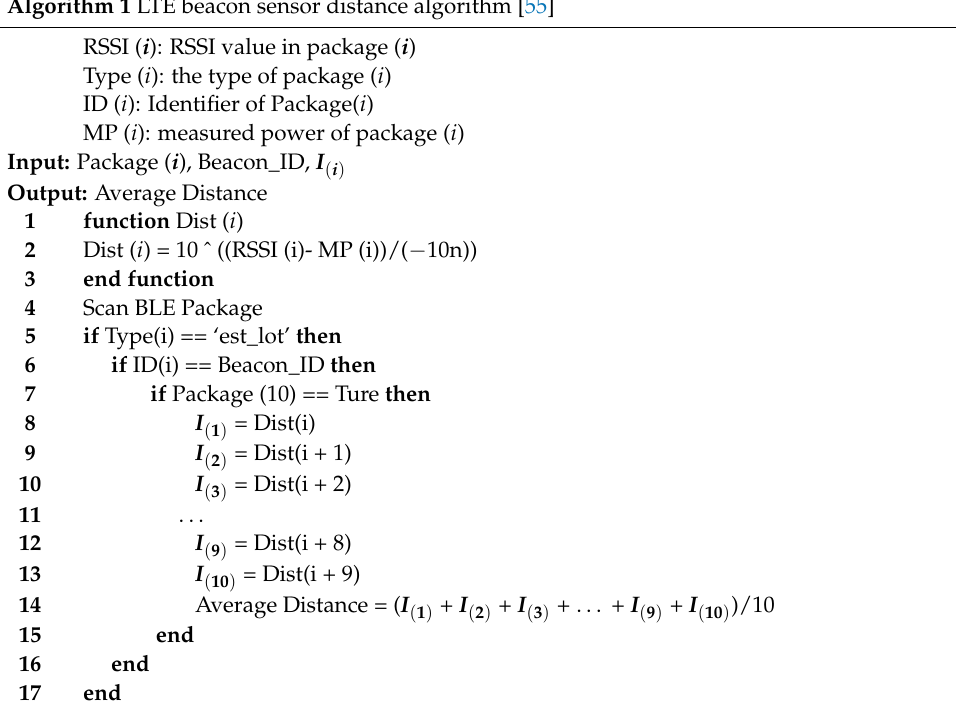
Algorithm 1 LTE beacon sensor distance algorithm